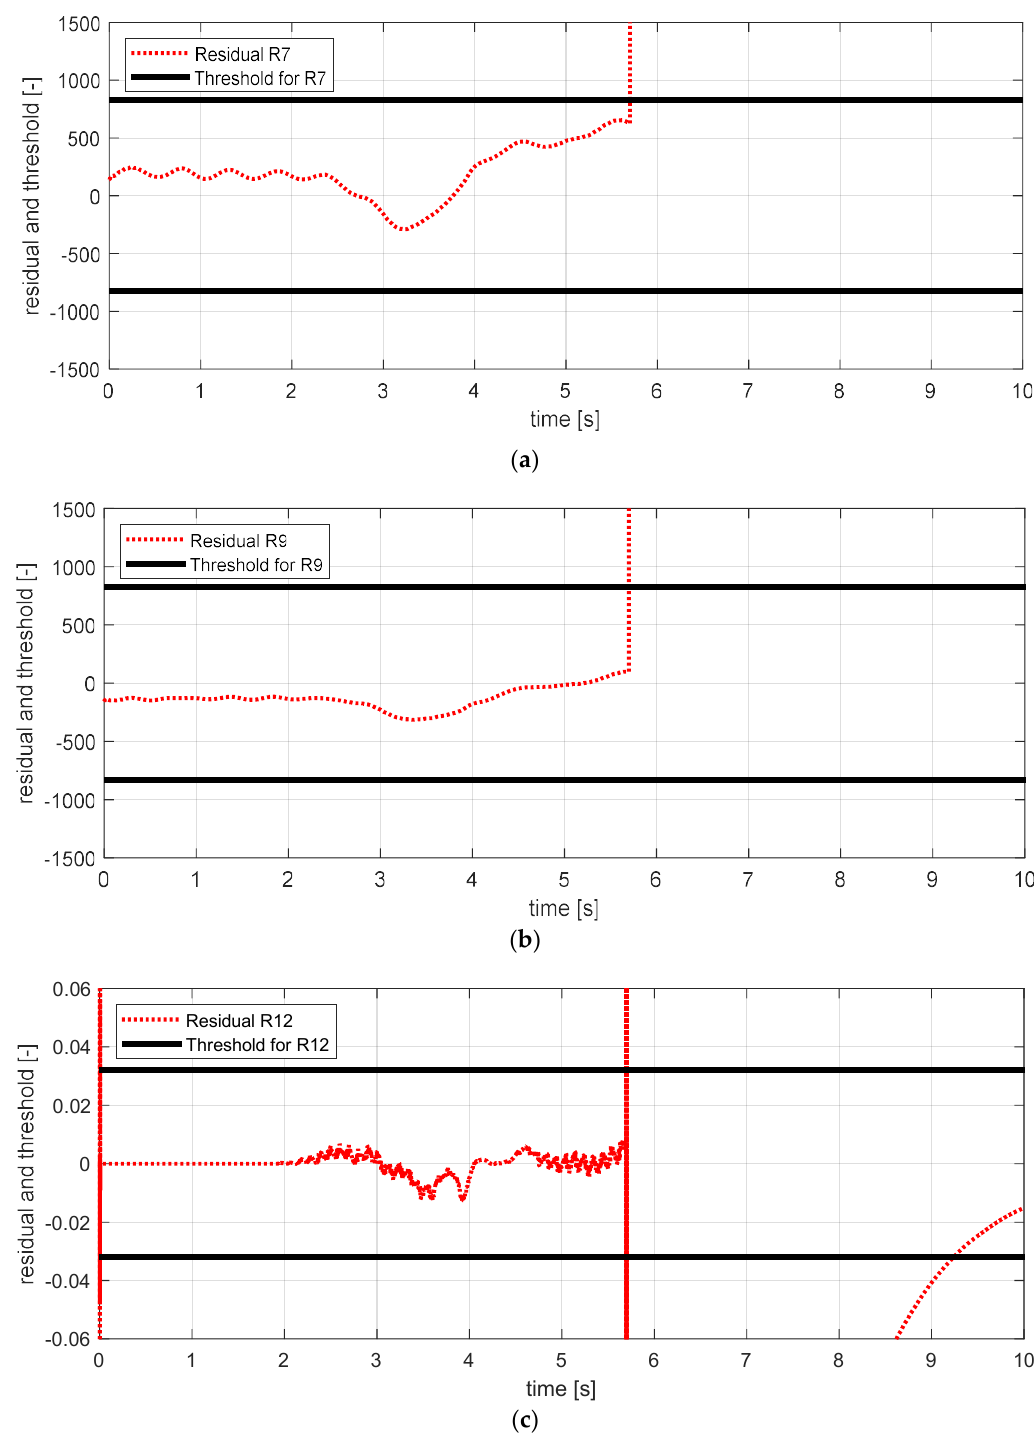
Figure 30. Simulation result for body vertical acceleration sensor—fl (fault). ( a ) Residual 7 and threshold; ( b ) residual 9 and threshold; ( c ) residual 12 and threshold.